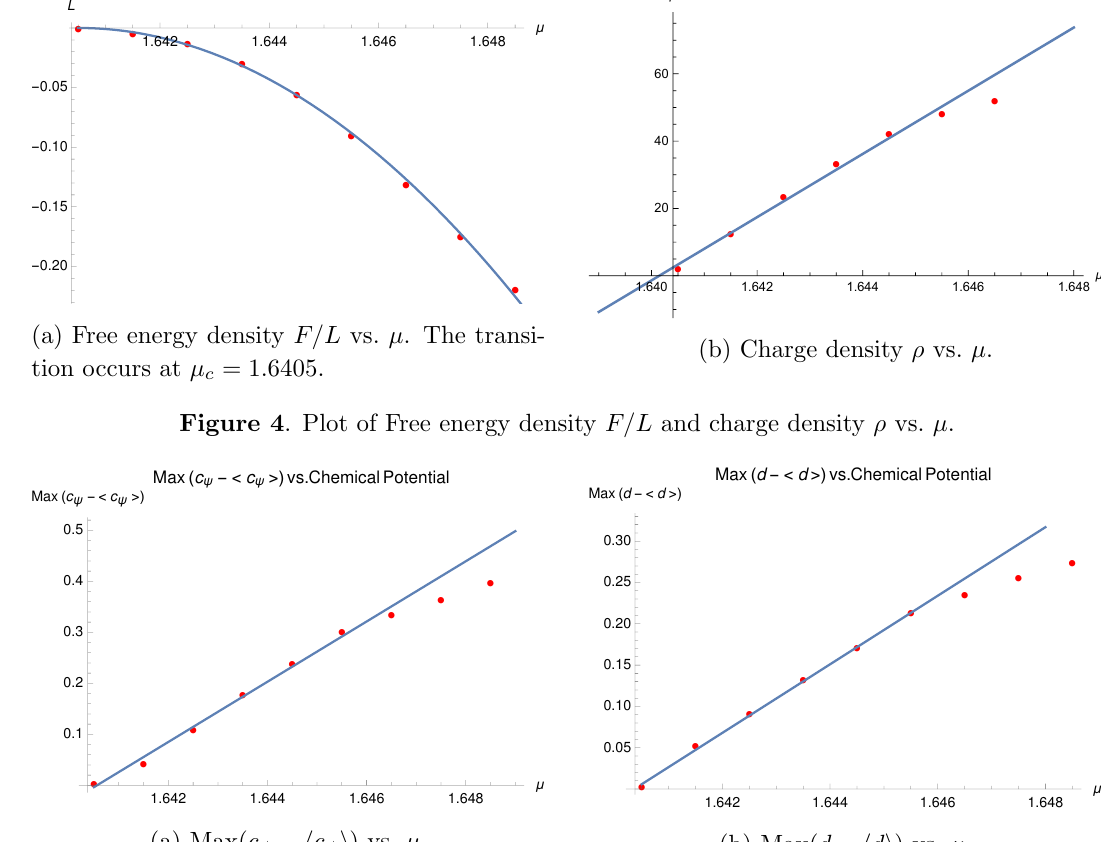
Figure 5 . Amplitudes of the spin density and the charge density waves vs. (cid:22)